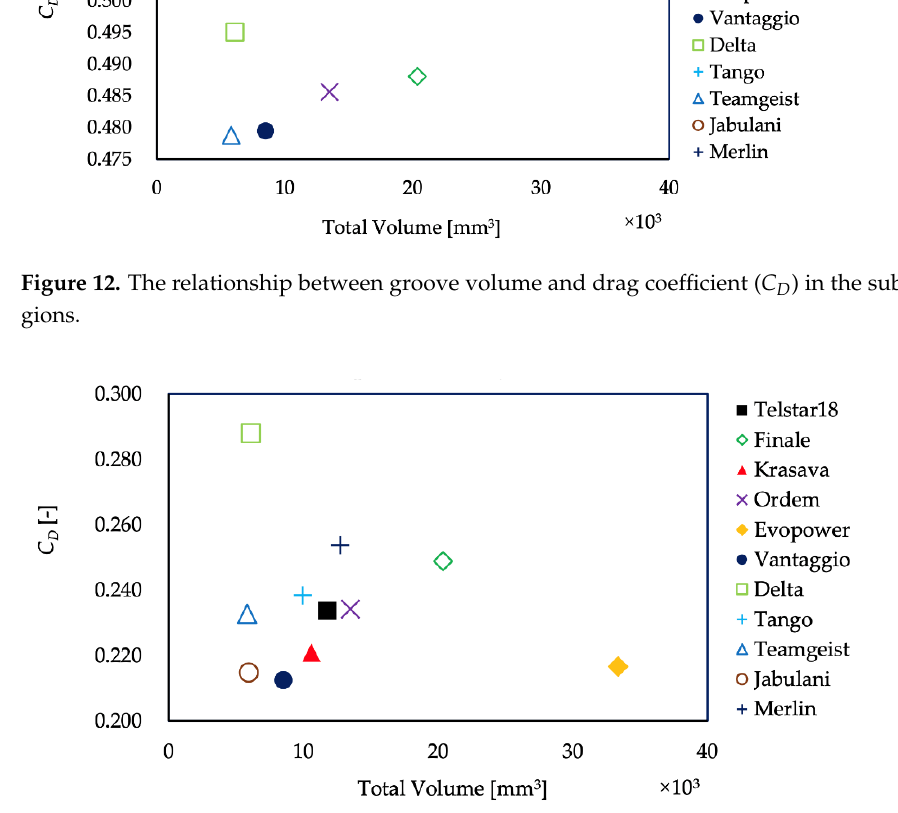
Figure 13. The relationship between groove volume and drag coefficient ( C D ) in the supercritical regions.